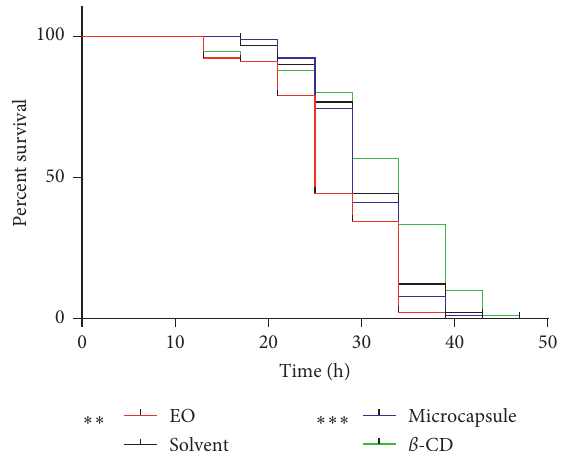
Figure 4: Essential oil of flesh fingered citrons and microcapsules affect the oxidative stress resistance of wild-type C. elegans . Results include at least three independent biological replicates. Statistical significance of the difference between the curves was demonstrated by a log-rank test using Kaplan − Meier survival analysis. Error bars represent the standard error, and differences compared to the solvent (0mg/ml, 0.1% DMSO) were considered significant at ∗ P < 0 . 05 , ∗∗ P < 0 . 01 , and ∗∗∗ P < 0 . 001 by one-way ANOVA and the LSD post hoc test.